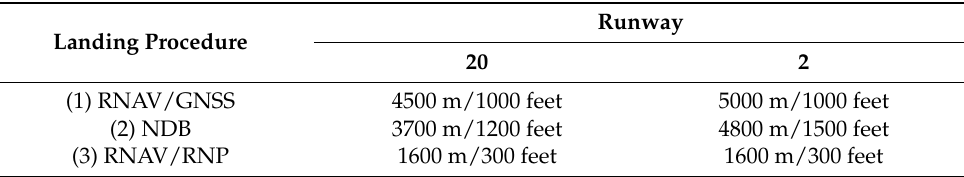
Table 1. Shows the operational limits for Vis and ceiling representing the three landing procedures on the runways of the SDA.